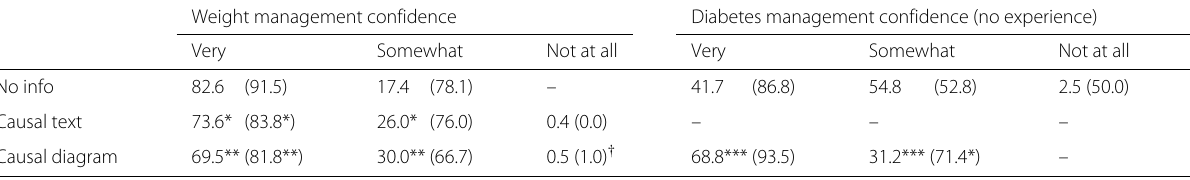
Table 3 Participant self assessment of confidence in Experiment